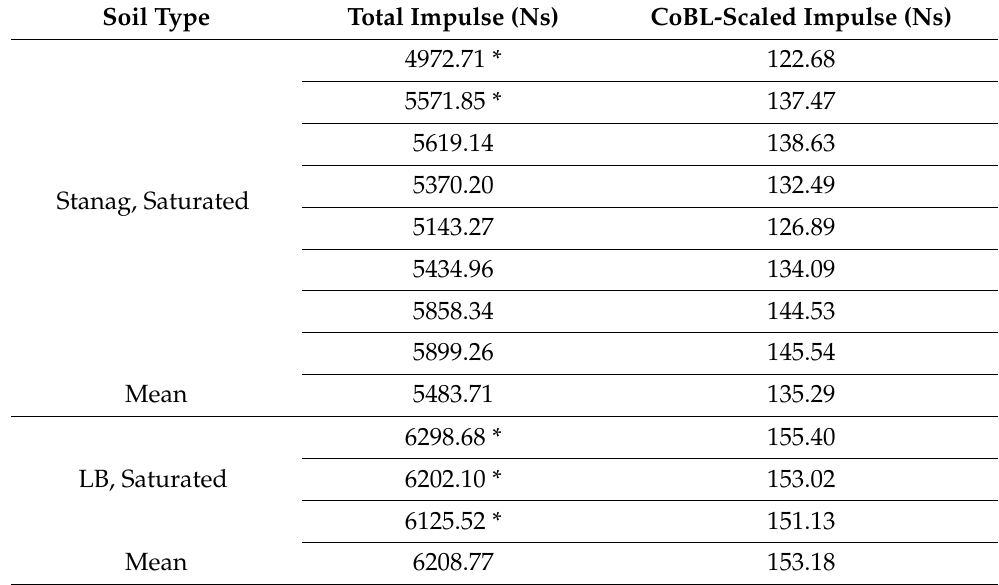
Table 5. Global impulse data from FFM testing, with impulse values scaled by the LB-equivalency scale factor (40.53). Results marked with * are from [28], with other data previously